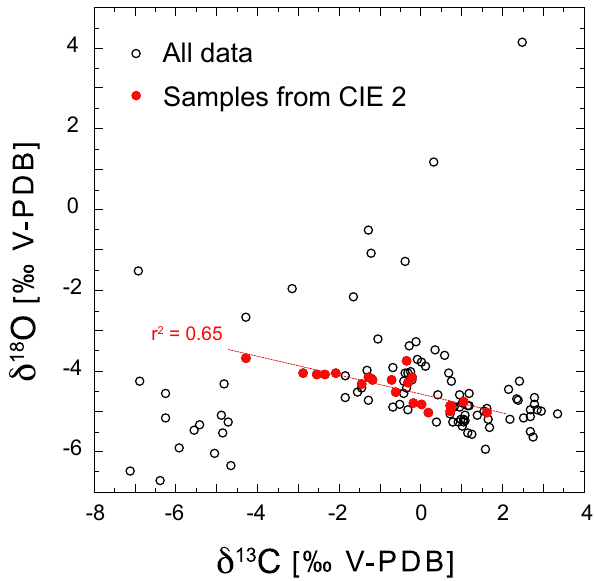
Figure 6. Scatter plot of carbon and oxygen isotopes in the Upper Pliensbachian and Lower Toarcian samples of Bascharage. Key for symbols is inset. In the serpentinum zone, coccolith-bearing sam- ples from the CIE 2 show an anti-correlation of their isotope ratios. Each of the subsequent negative step of the carbon isotope excur- sion is seen with a concomitant ∼ 1.5‰ increase in oxygen iso-